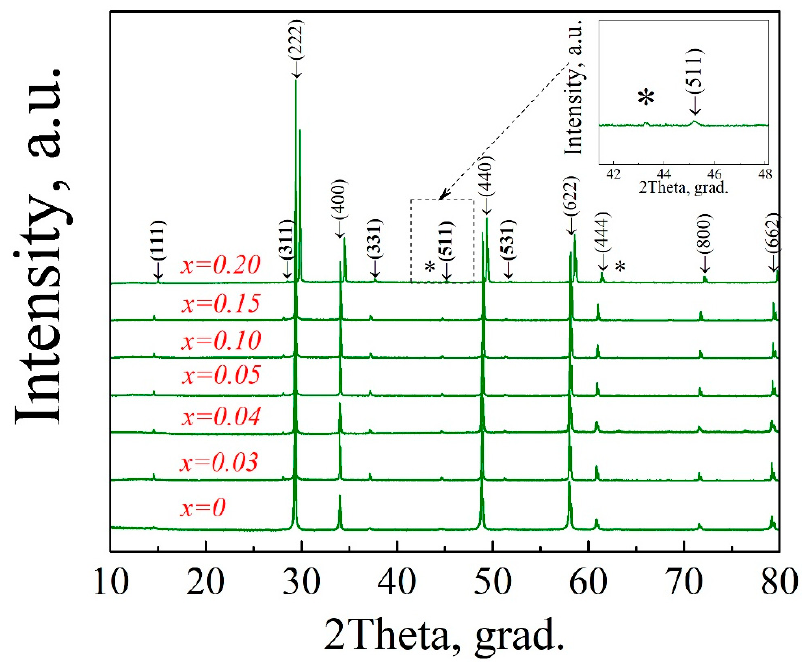
Figure 1. XRD patterns of Gd 2 − x Mg x Zr 2 O 7 − x/2 (x = 0, 0.03, 0.04, 0.05, 0.10, 0.15, 0.20). Numbers in parenthesis are the pyrochlore Miller indexes of each reflection (PDF Card No.: 01-080-7637). Superstructure pyrochlore Muller indexes are shown in bold. Magnesium oxide impurity is shown by asterisks (PDF Card No.: 01-075-0447). The insert shows an enlargement of some area of the XRD patterns.